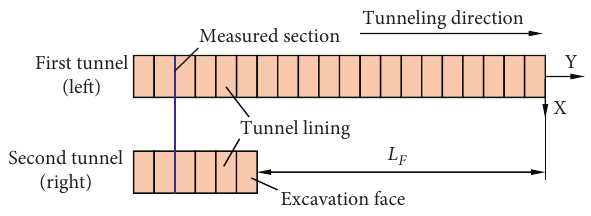
Figure 4: Plan view of twin tunnels (not to scale).